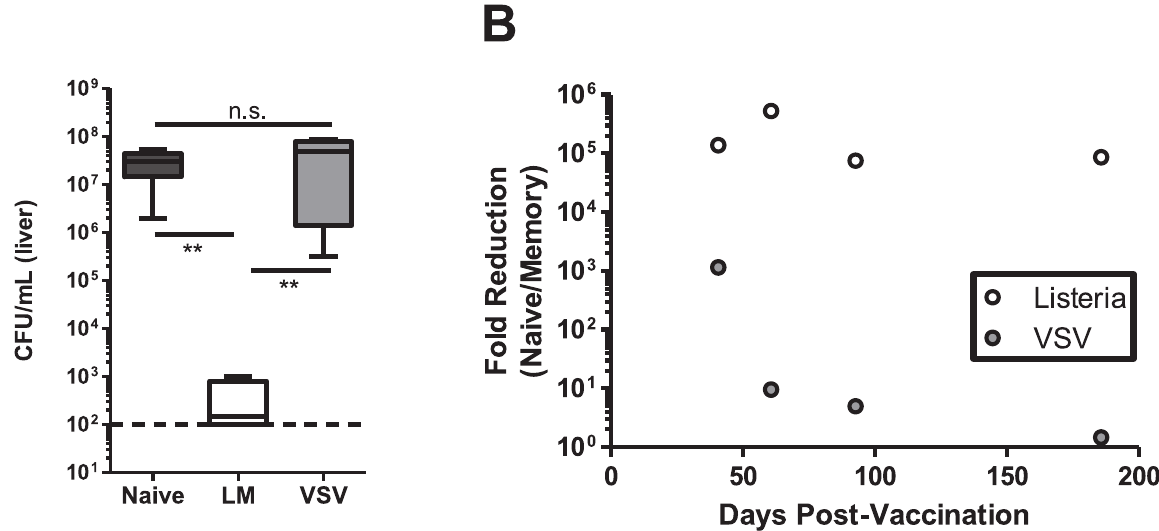
Figure 1. Protective immunity induced by VSV is short lived. C57BL/6 mice were i.v infected with 2 6 10 5 pfu VSV-ova or 2 6 10 3 cfu LM-ova. (A) 180 days after primary infection mice were re-challenged with 5 6 10 5 cfu LM-ova. Three days later livers and spleens (data not shown) were plated to assess bacterial burden. Statistical significance was determined using a one-way ANOVA with a Bonferroni’s post-test (**p , 0.01). (B) Naı¨ve C57BL/6 or memory mice infected 30, 60, 90, or 180 days previously with either VSV-ova or LM-ova were challenged with 5 6 10 5 CFU of LM-ova. Three days post-challenge bacterial burden was quantified in the spleen and liver. The fold reduction of LM-ova burden at 72 h post-challenge in vaccinated versus naı¨ve animals was calculated from representative time-point out to , 6 months post-vaccination. This was done by dividing the LM burden in the naı¨ve animals by those found in vaccination animals to get a fold-reduction in LM burden. Data are representative of at least two independent experiments at each time-point.